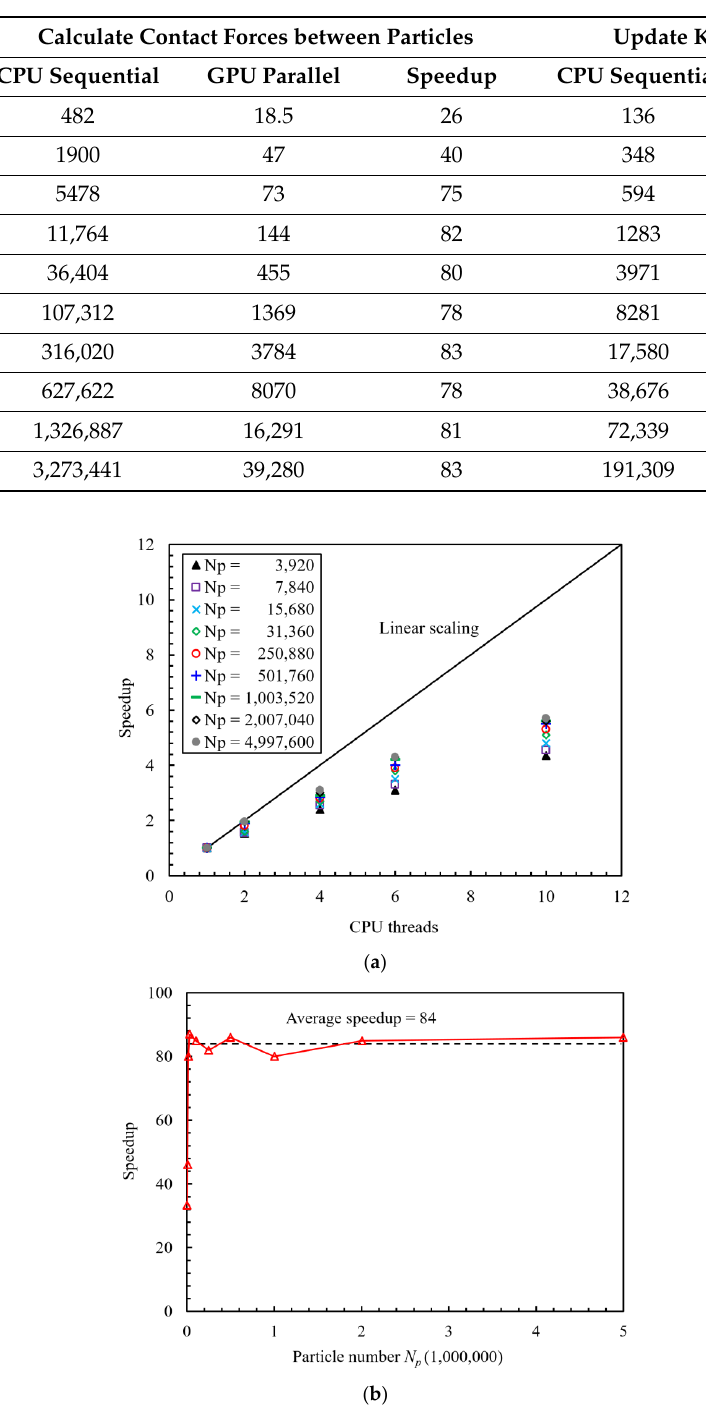
Figure 7. Speedups of the CPU and GPU parallelisation for the triaxial test. ( a ) CPU parallelization ( b ) GPU parallelisation